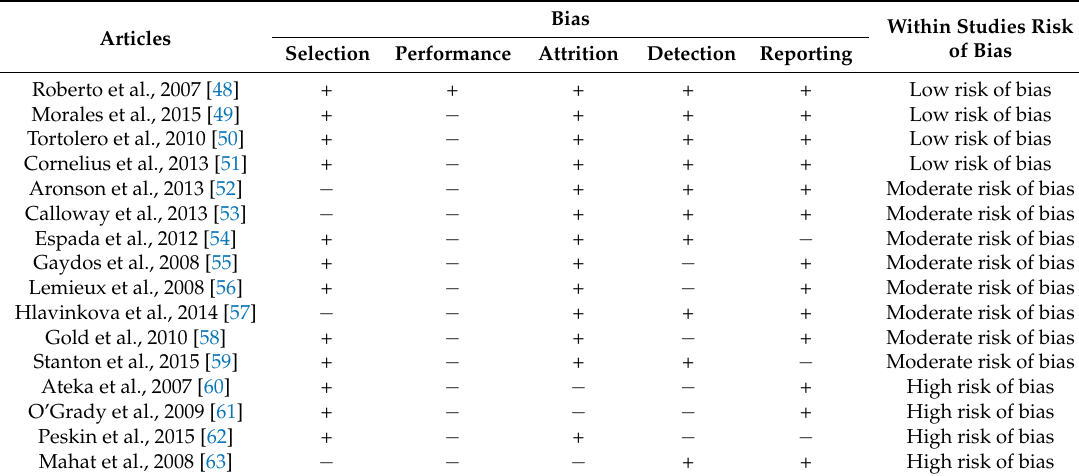
Table 1. Summary of risk of bias